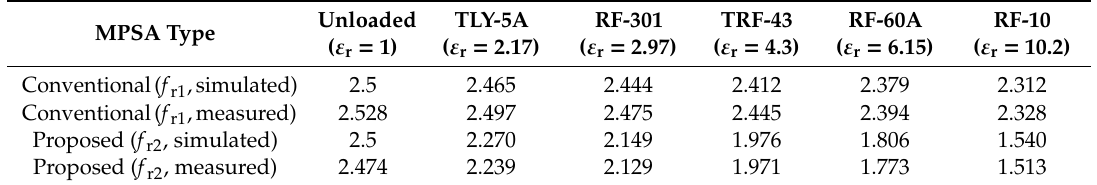
Table3. SimulatedandmeasuredresonantfrequenciesofS 11